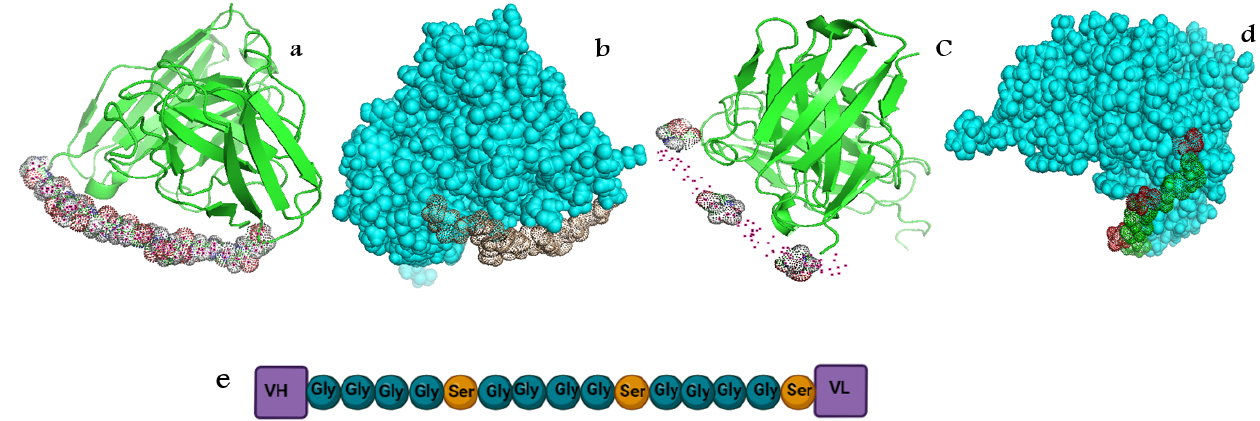
Figure 6. ( a , c ): two-dimensional structure of scfv. ( b , d ): spatial structure of scFv. In these struc- tures, linkers are illustrated with different colors, and bold regions in ( c , d ) are serine amino acids. ( e ): schematic structure of scFv.